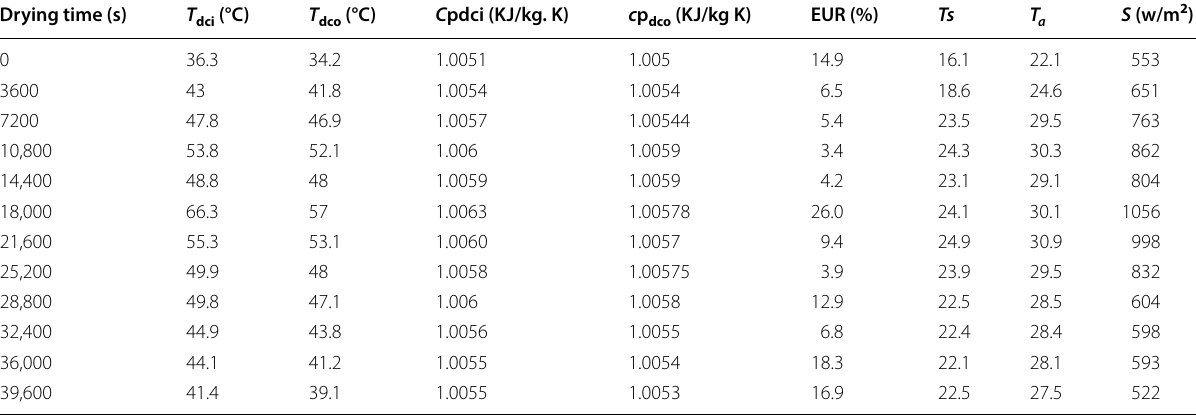
Table 14 Result energy analysis tomato 2nd